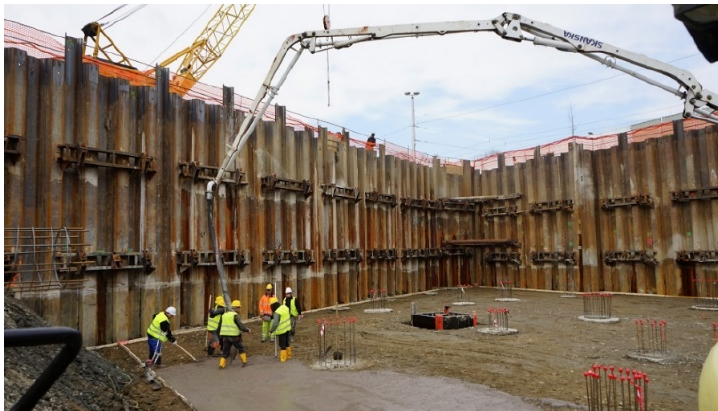
Figure 5. The first ready mix concrete placement.